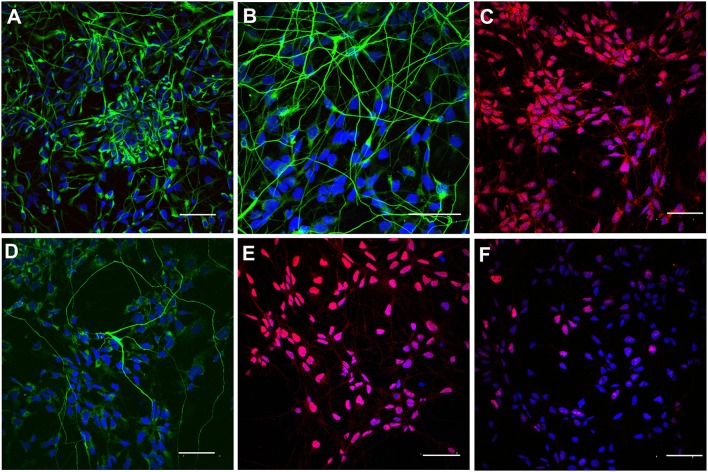
Immunocytochemical staining of pre-differentiated iPSC-NPs prior to transplantation. (A) Nestin, (B) βIII-tubulin, (C) NG2, (D) NF-68, (E) Olig2, (F) Ki67; magnification −20 μm.